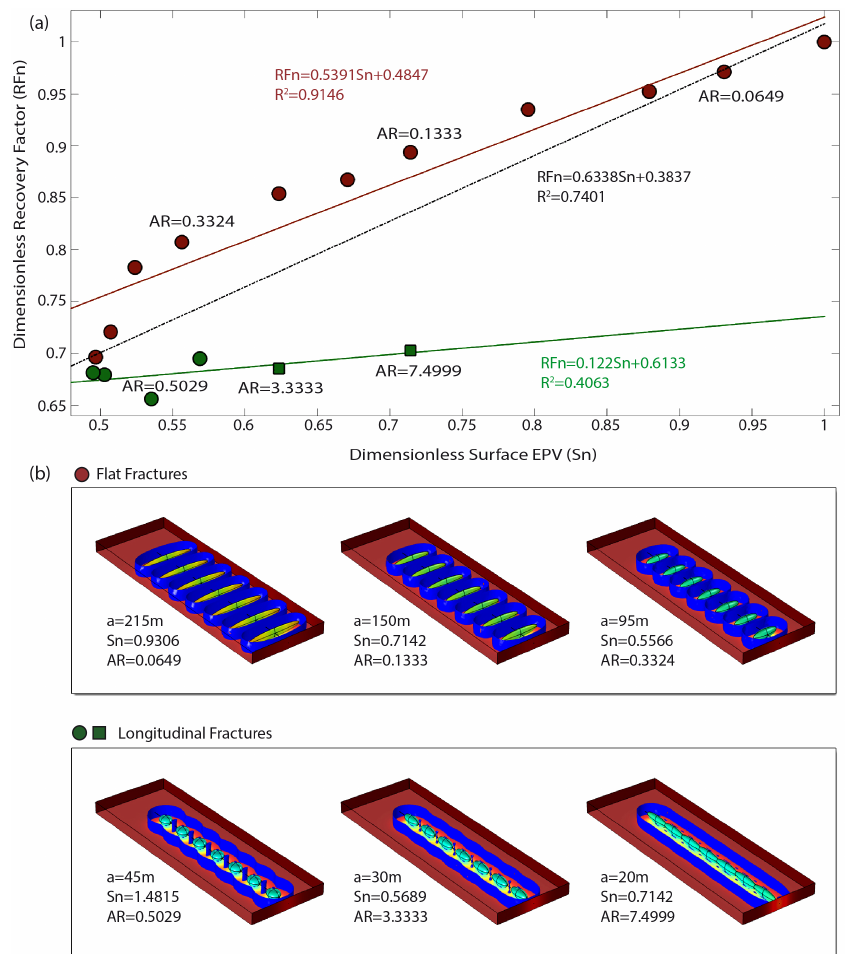
Figure 9. Graphic explanation of the impact of EPV geometry on shale gas production performance. ( a ) Correlation of Sn and RFn. ( b ) Snapshots of BCa with pressure state and isosurface of 5 KPa/m (dark blue surface) after 365 days of simulation. a is the semiaxis of the EPV perpendicular to the well and in the same plane as the SRV. b is the semi-axis of the EPV longitudinal to the well and in the same plane as the